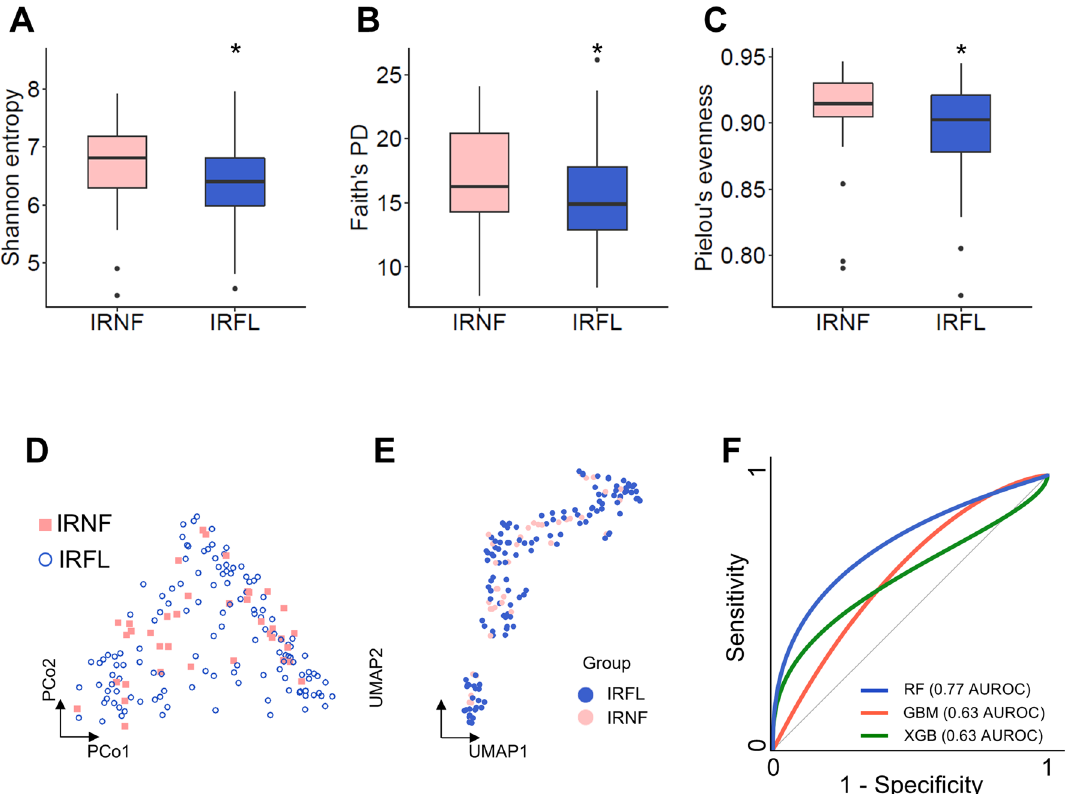
Figure 3. Comparing the alpha and beta diversity of the gut microbiome of IRNF and IRFL. ( A – C ) Alpha diversities of IRNF and IRFL were measured using Shannon’s entropy ( A ), Faith’s phylogenetic diversity (PD) ( B ), and Pielou’s evenness ( C ). Boxes represent the IQR. The upper whiskers represent the range from minimum (upper quartile − 1.5IQR) to maximum (lower quartile + 1.5IQR), and black dots represent outliers excluded in the range. (D–E) Beta diversity among participants in IRNF and IRFL was measured using PCoA (D) and UMAP analyses (E). (F) The model’s predictive power featuring different number of gut microbial genera constructed using RF, GBM, and XGB algorithms in the test dataset. The statistical significances were analyzed using Wilcoxon’s test. * p < 0.05, ** p < 0.01. IRFL, fatty liver participants featuring insulin resistance; IQR: interquartile range; IRNF: nonfatty liver control group featuring insulin